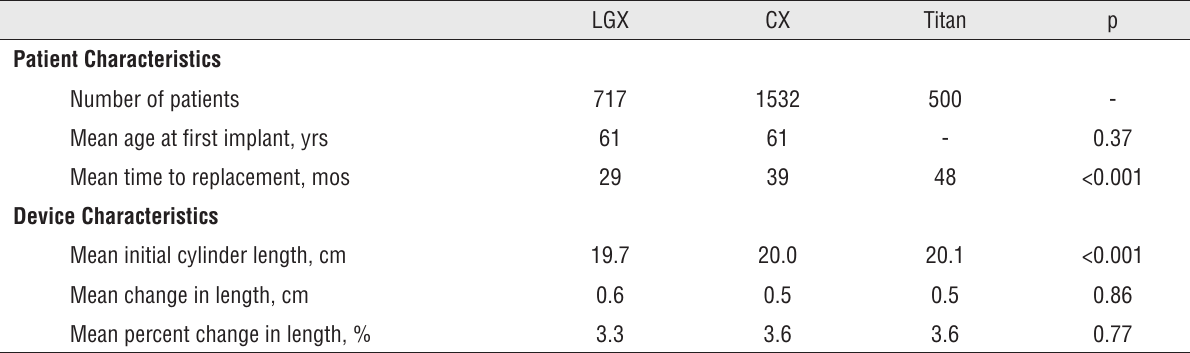
Table 1 - Patient and Device Characteristics for AMS 700 LGX, AMS 700 CX, and Coloplast